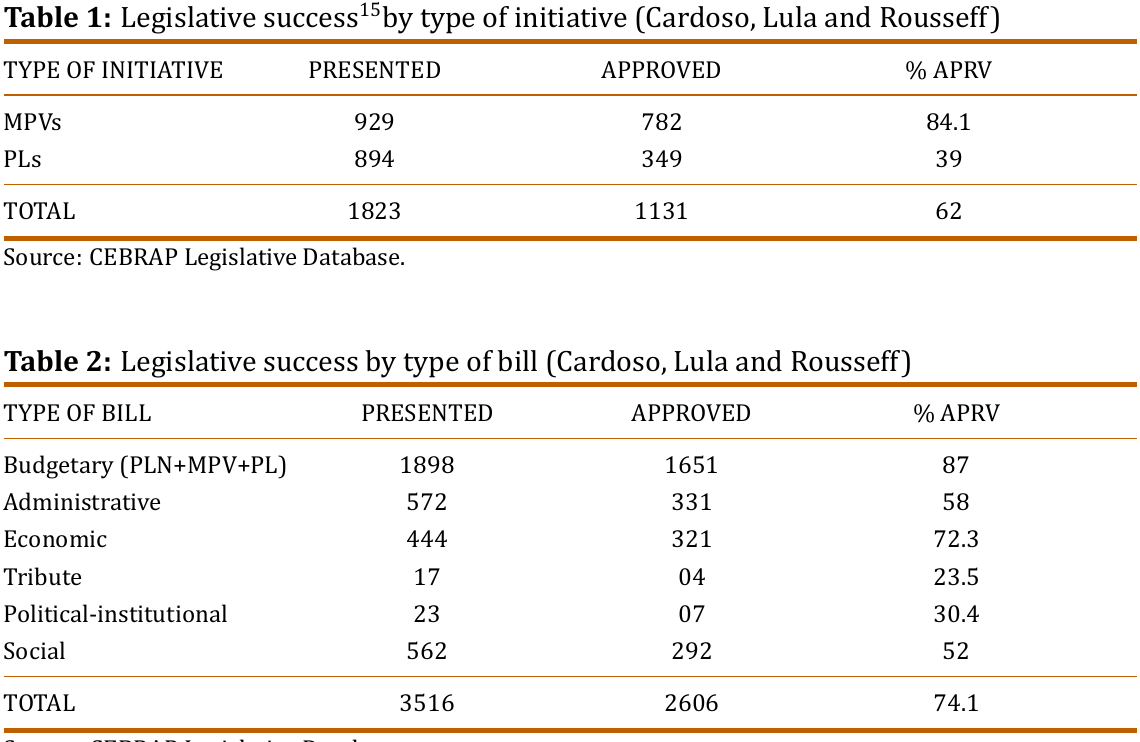
Source: CEBRAP Legislative